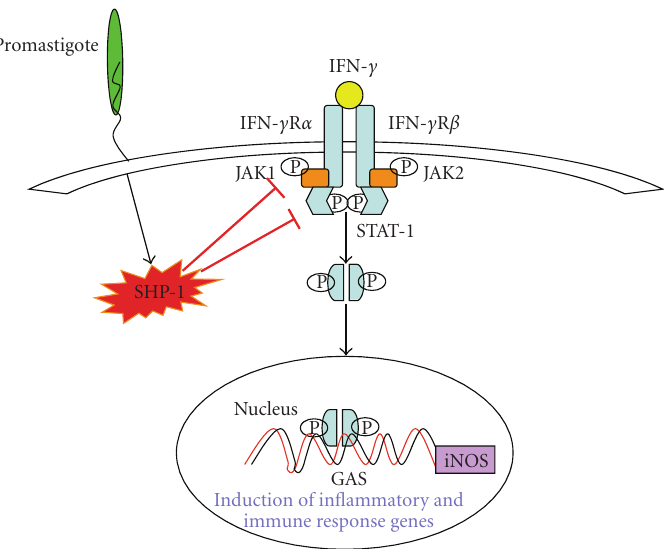
Figure 3: STAT1 phosphorylation regulation through IFN γ receptor: infected macrophages display reduced levels of total and phosphorylated JAK1 and JAK2 and attenuate IFN- γ induced STAT-1 phosphorylation in macrophages, aiding the parasites in escaping host immunity. GAS: Interferon gamma-activated site.